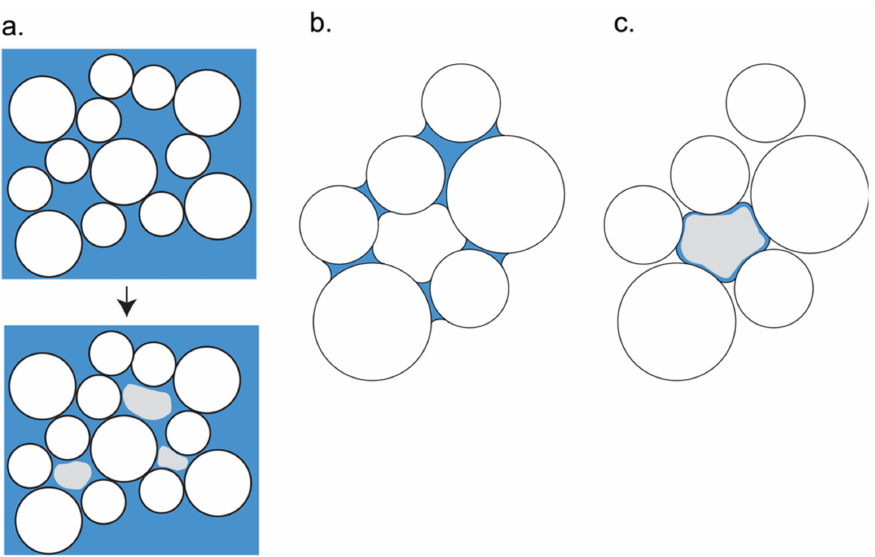
Figure 18. Conceptual illustration of hydrate formation reprinted from [60] with permission from Elsevier. ( a ) Hydrate formation from dissolved gas; ( b ) hydrate formation from the partial water saturation method; ( c ) when hydrate forms it occupies the larger pores due to redistribution of